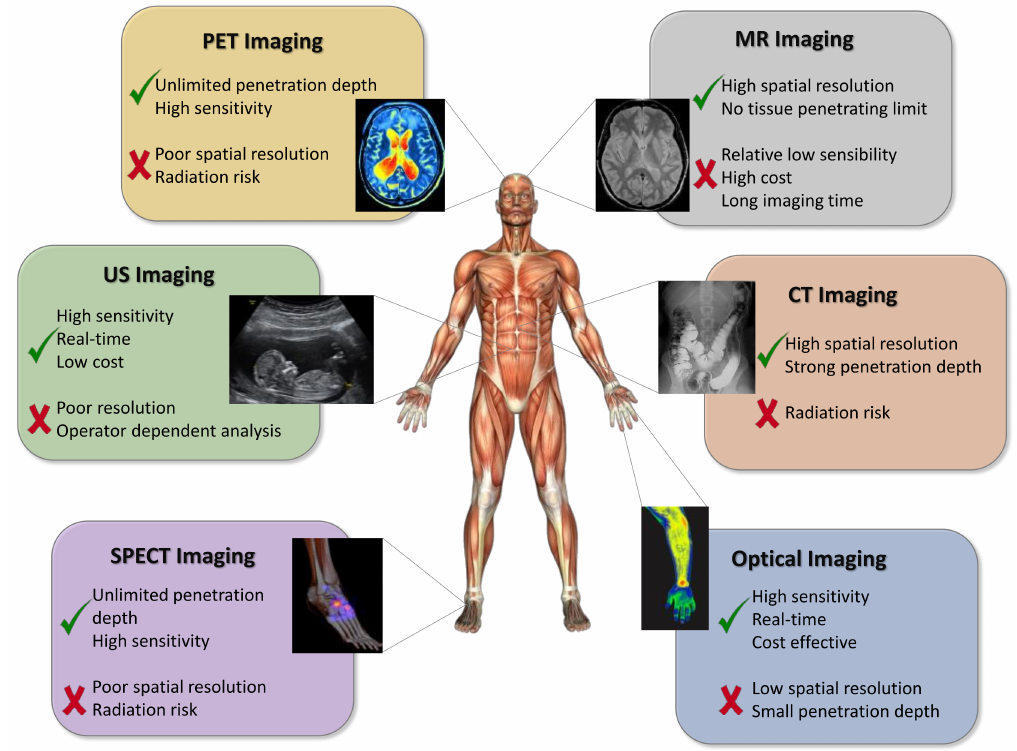
Figure 1. Schematic representation of different molecular imaging modalities. Adapted with permission from [15], Copyright 2021 Elsevier